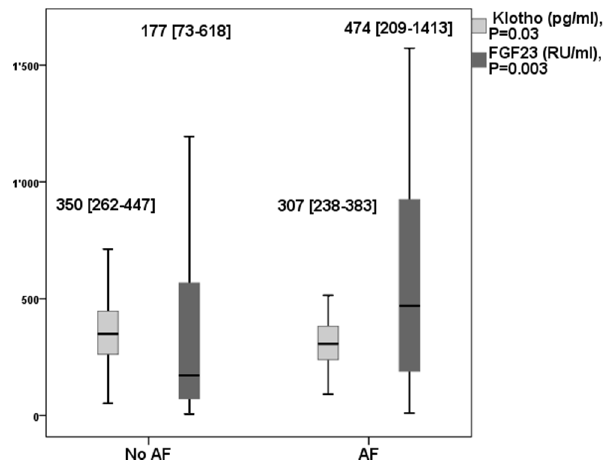
Figure 3. Klotho and FGF23 levels in patients with and without atrial fibrillation.